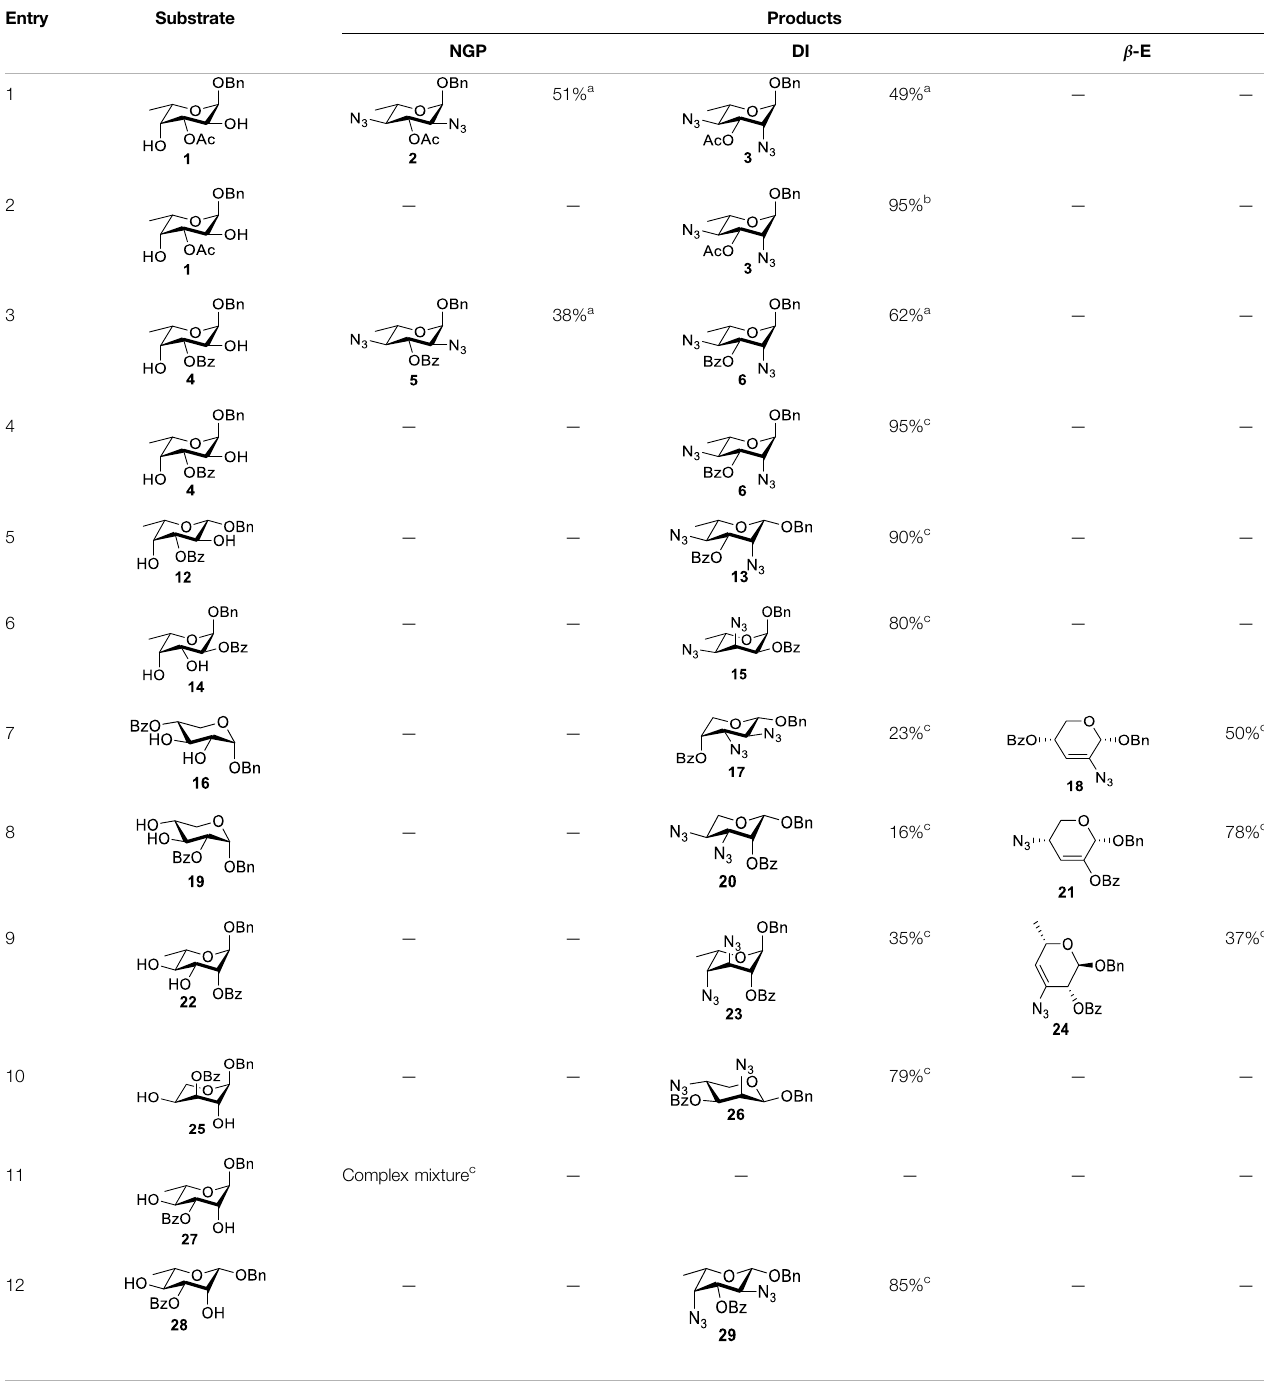
TABLE 1 | Competition of NGP, double inversion, and β -elimination. Entry